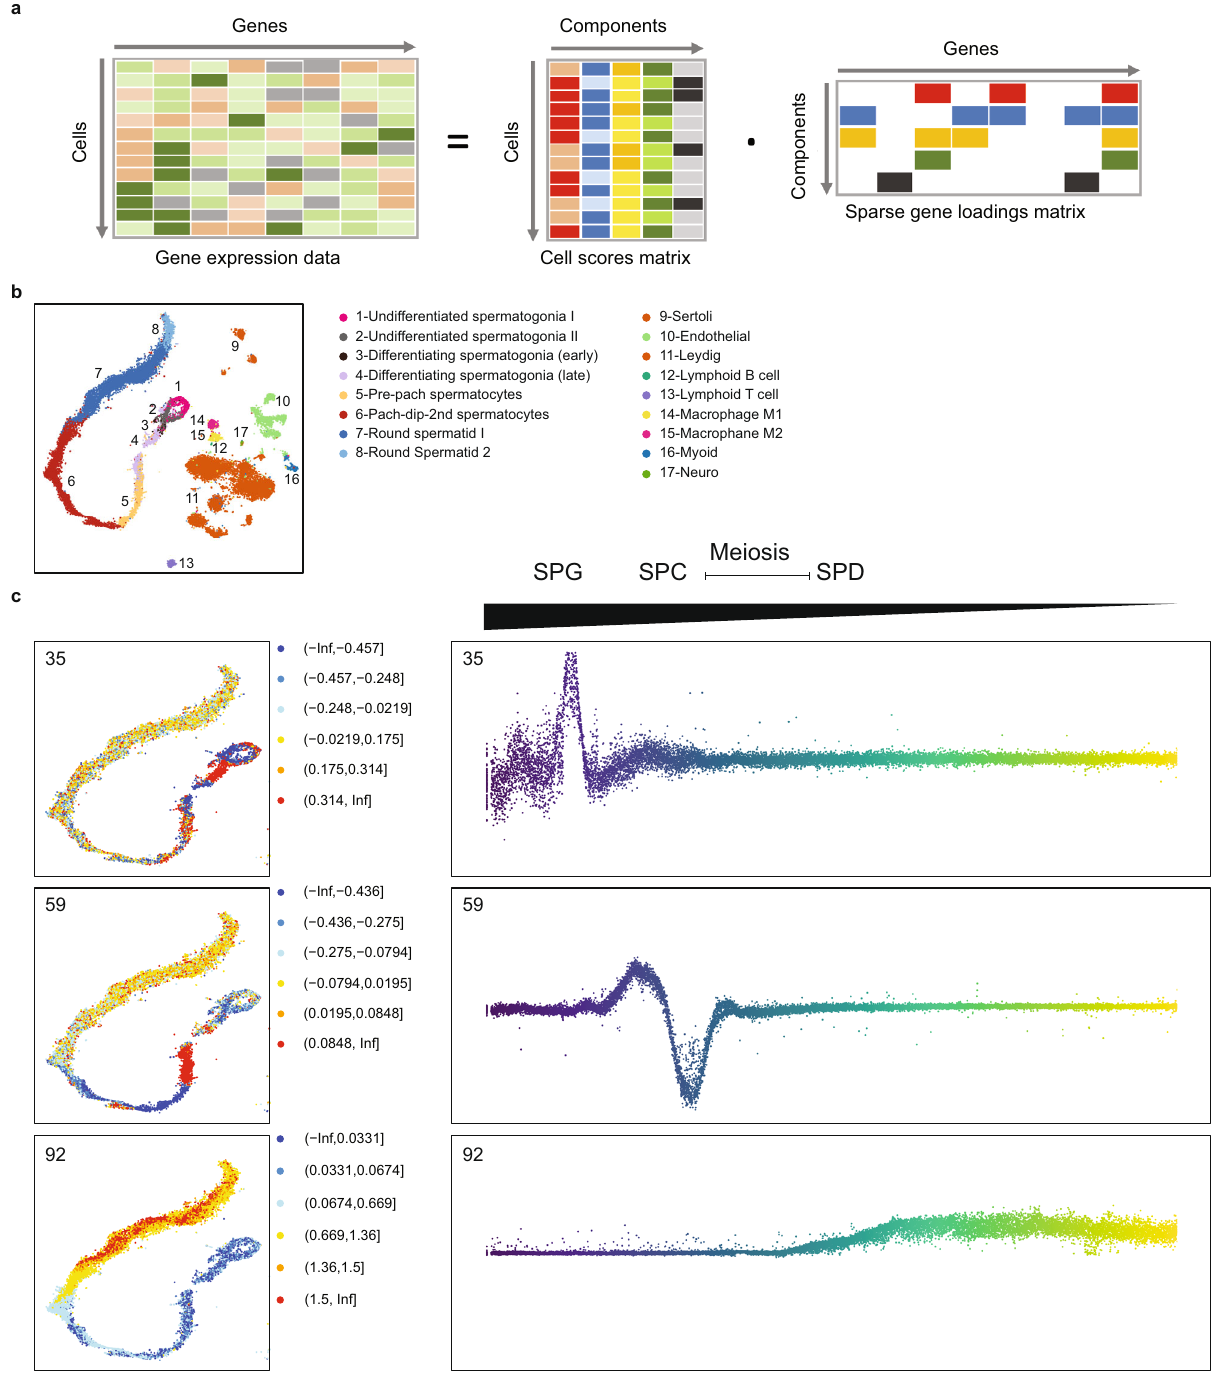
Fig. 4 | Decomposition of testis gene expression patterns with sparse decom- position of arrays (SDA). a We applied sparse decomposition analysis (SDA) to testis scRNA-seq data from 12 human donors to identify latent factors ( ‘ compo- nents ’ ) representing gene modules. These components are de fi ned by two vectors – one that indicates the loading of each cell on the component, and one that indicates the loading of each gene on the component. b The same scRNA-seq data wassummarized usingaconventionaltSNEanalysis,and testicularcelltypeslabels